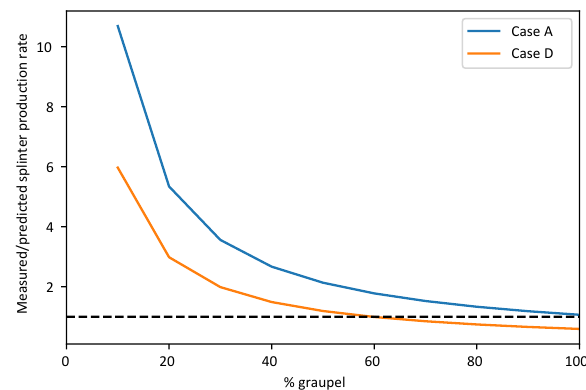
Figure 9. The mean ratio of the measured to the predicted splinter production rate for Cases A and D, as a function of the percentage of particles sampled by the 2DP assumed to be graupel. Calculations were performed over all penetrations having more than 80% of the particles identified as aspherical. The dashed line corresponds to a perfect match of measured and predicted splinter production